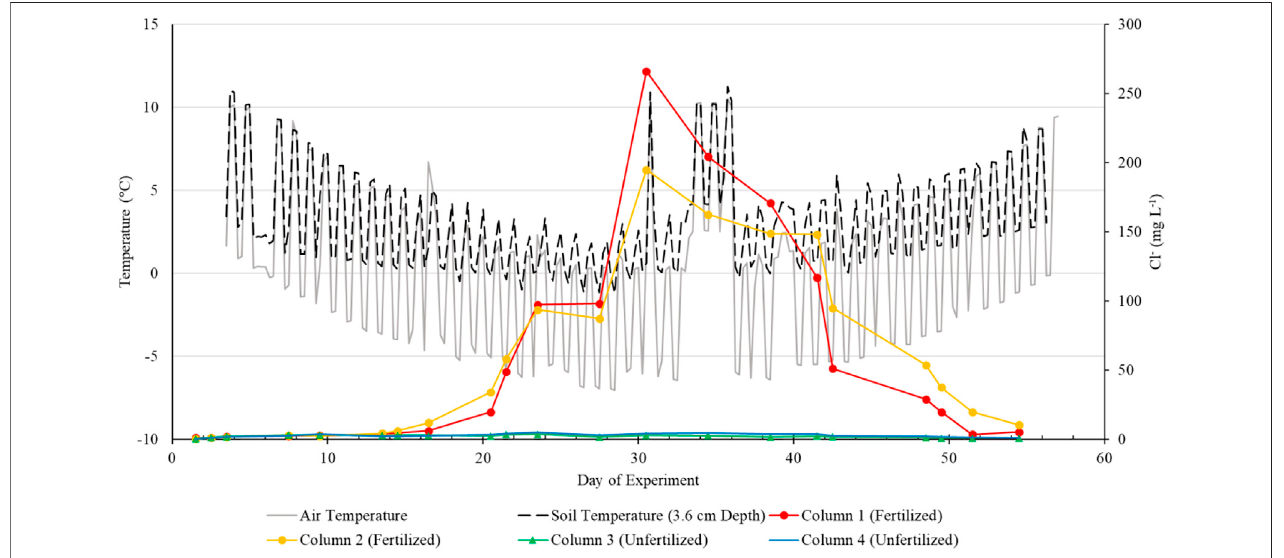
FIGURE 3 | Temperature and leachate Cl − concentrations versus time for fertilized and unfertilized columns.